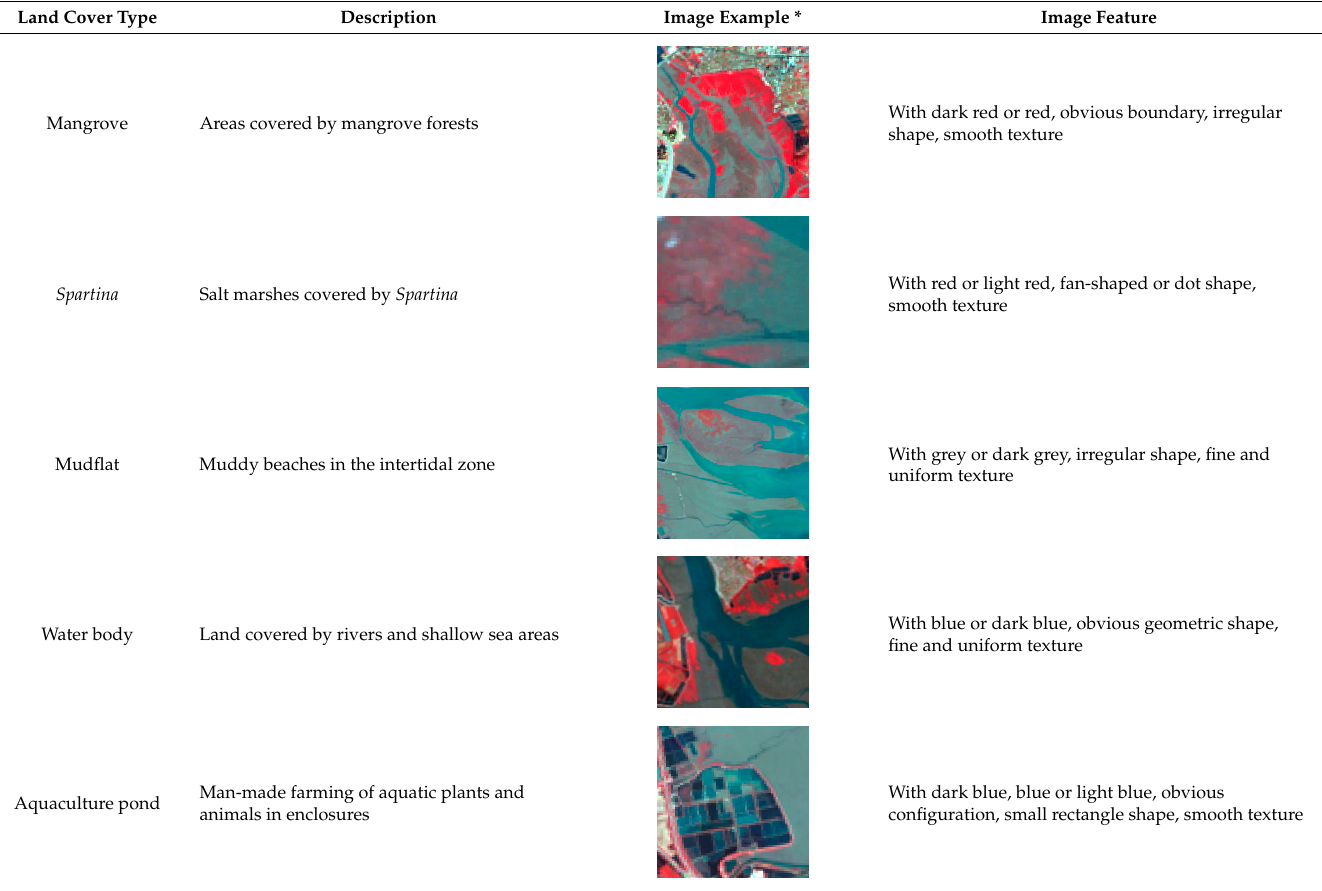
Table 2. Description of the landscape classification system and image feature.